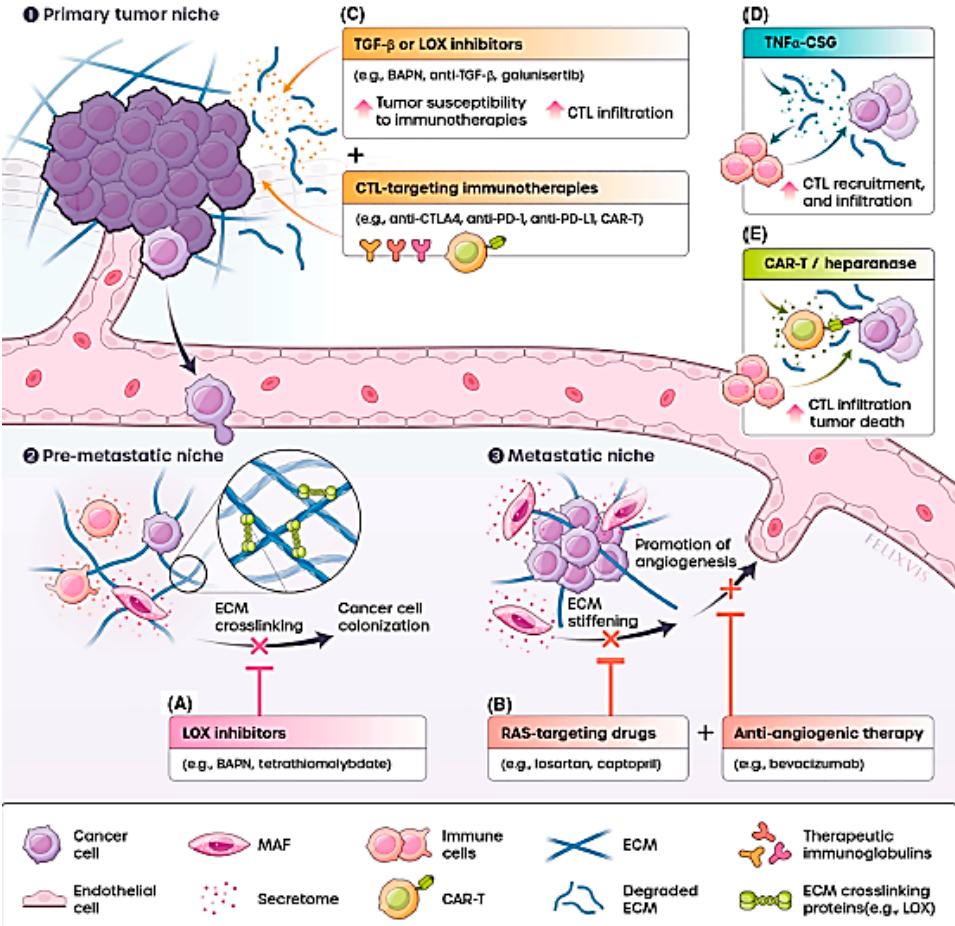
Figure 14. Targeting stiffness in primary and metastatic tumour niches. ( A ) Lysyl oxidase (LOX) inhibitor therapy prevents tumour metastasis by destructing the premetastatic niche, thereby inhibiting cancer cells from colonization. ( B ) Antiangiogenic therapy for the treatment of metastatic cancer by drugs that target the renin-angiotensin system (RAS), and inactivating metastasis-associated fibroblasts (MAFs), which stimulate angiogenesis in the metastatic niche. ( C ) Tissue-softening tech- niques combined with CTL-targeting immunotherapies, such as immune checkpoint inhibitors and chimeric antigen receptor-T (CAR-T) cells, the infiltration of cytotoxic T lymphocytes (CTLs) in- creases. ( D ) Recruitment of CTLs into tumour lesions is accompanied by the degradation of tumour ECM by the fusion protein (TNF-CSG), which binds to laminin-nidogen complexes in tumour ECM. ( E ) Heparanase, an enzyme that breaks down the ECM, is expressed by CAR-T cells, which increases their capacity to penetrate the ECM [156]. Reproduced with permissions from Jeongeun Hyun et al., Trends in Molecular Medicine , Elsevier,